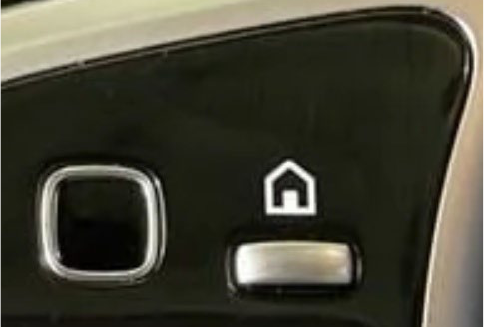
Figure 11. Laser engraving of the parts.